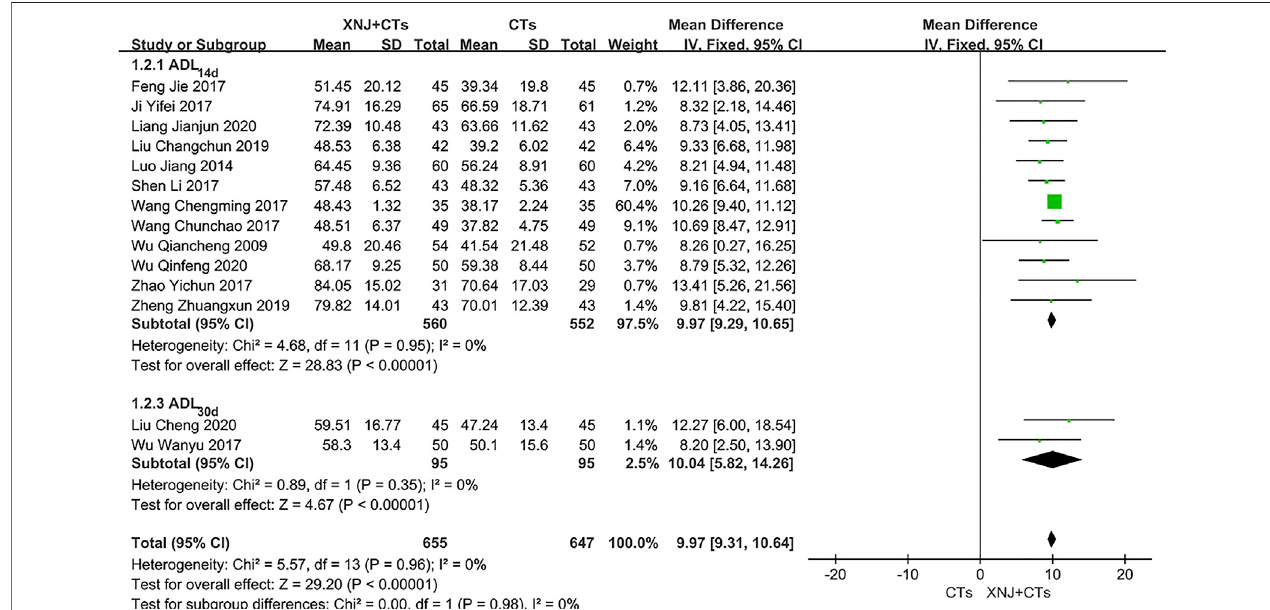
FIGURE 5 | Forest plot of the ADL – Barthel score.